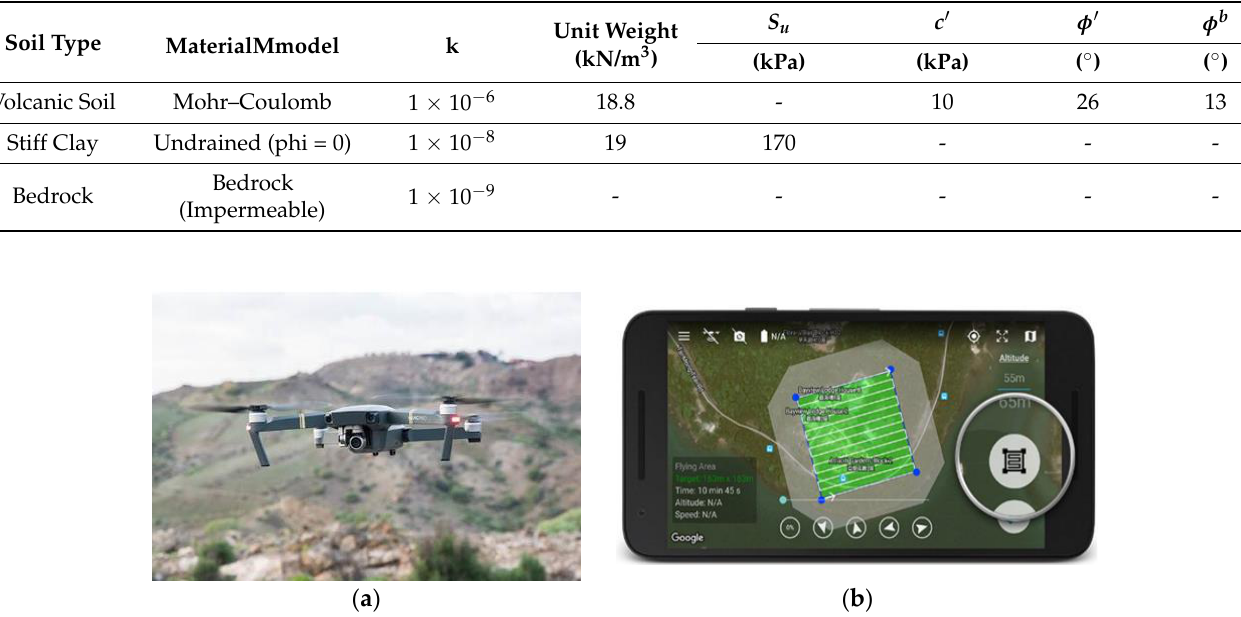
Table 3. Adopted Parameters for Simulation.